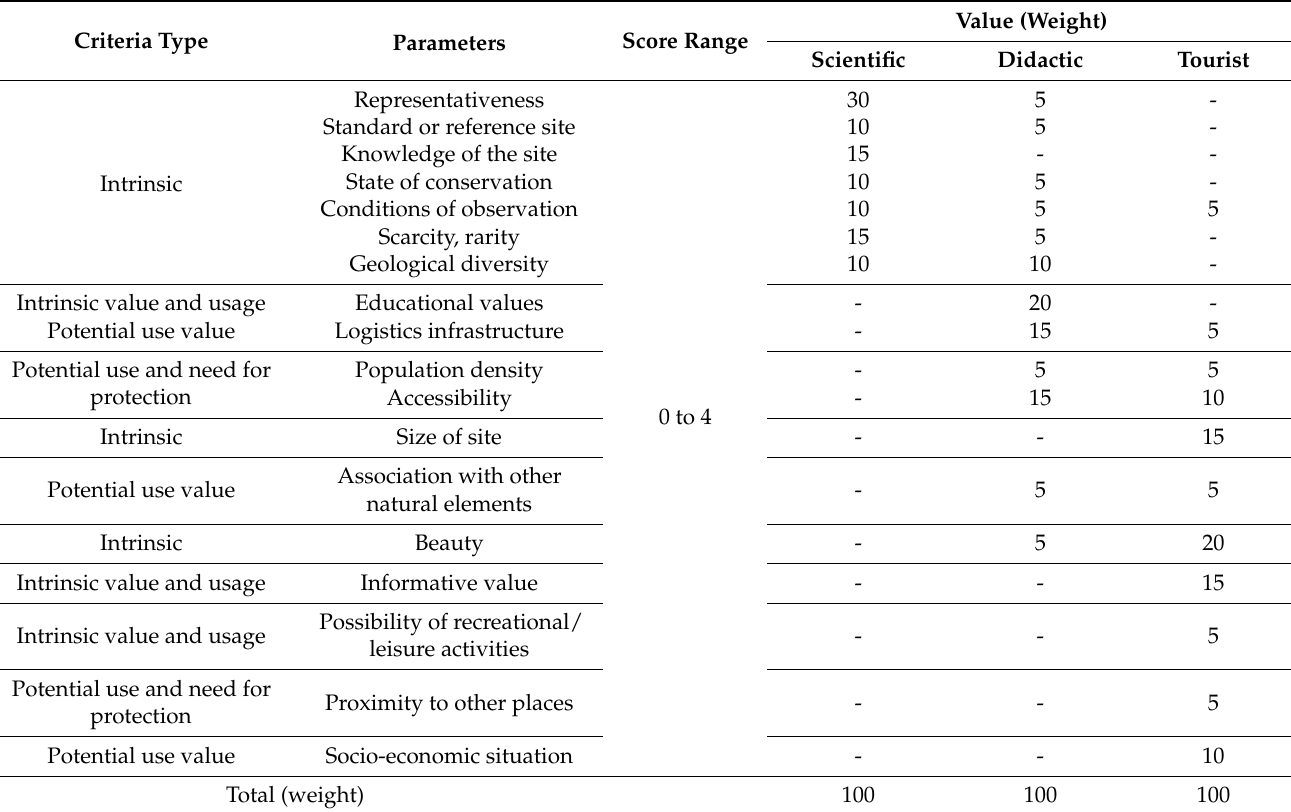
Table 1. Valuation parameters used in the semi-quantitative geosite assessment detailed the criterion, type of value (scientific, didactic, and tourist), and weights assigned to each parameter [17].